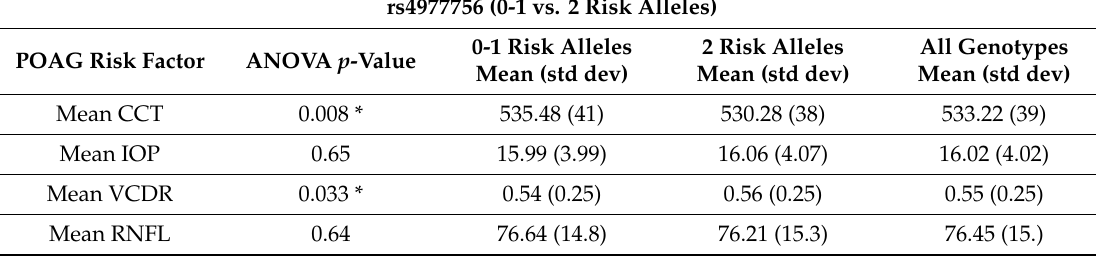
Table 4. Relationship between rs4977756 recessive model and quantitative POAG risk factors. The bottom panel includes the p-values for the follow-up linear regression analyses for central corneal thickness (CCT) and vertical cup to disc ratio (VCDR) controlling for age, sex, and disease status. * denotes a statistically significant result ( α =